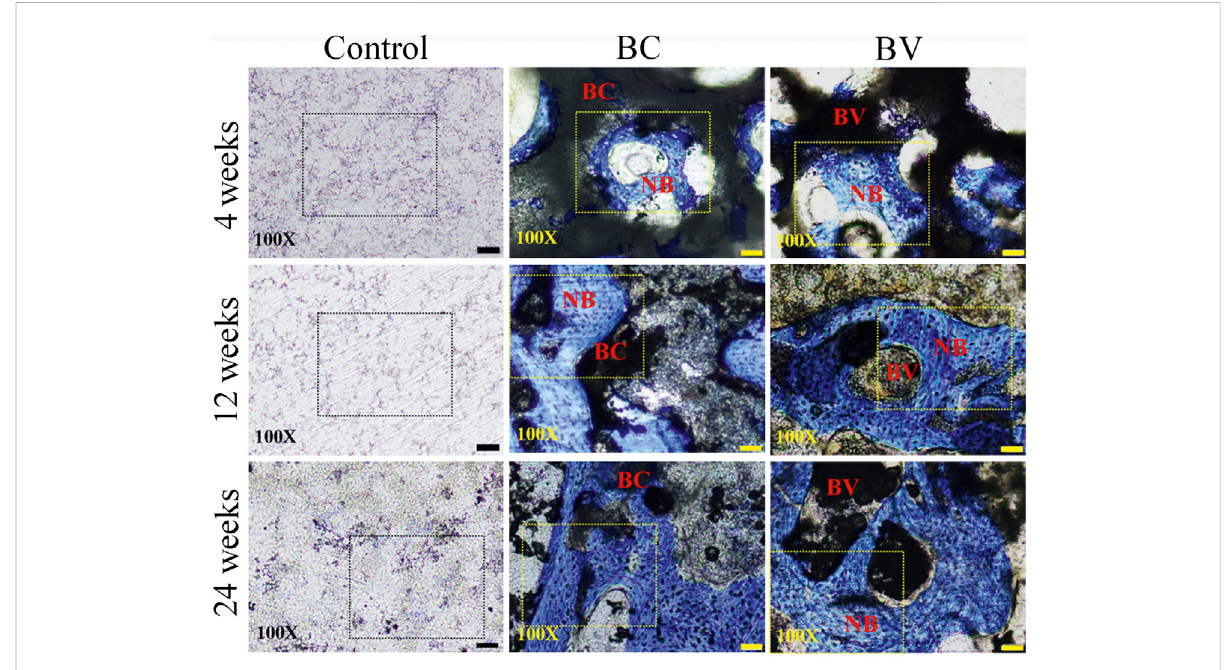
FIGURE 3 Histological imageofrabbitfemoralcondyletissuesection.Inthecontrol group,no fi brous tissueorin fl ammationresponsecouldbeobserved around the defect site (black dashed rectangle). In the BC and BV groups, new bone cells (blue area inside the yellow dashed rectangle) could be observed at 4, 12, and 24 weeks after implantation. The scale bar represents 50 μ m in 100X. NB, New bone. (BC, Bicera ™ ; BV, Vancomycin-loaded Bicera ™ .)